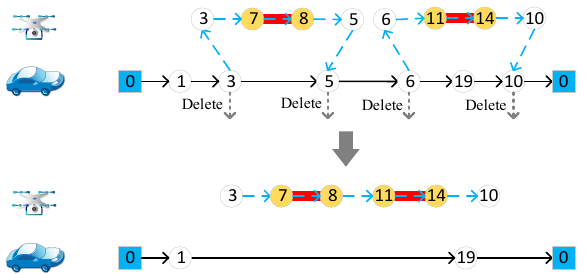
Figure 8. Merge two drone routes. Different numbers in the figure represent different nodes of the road network.